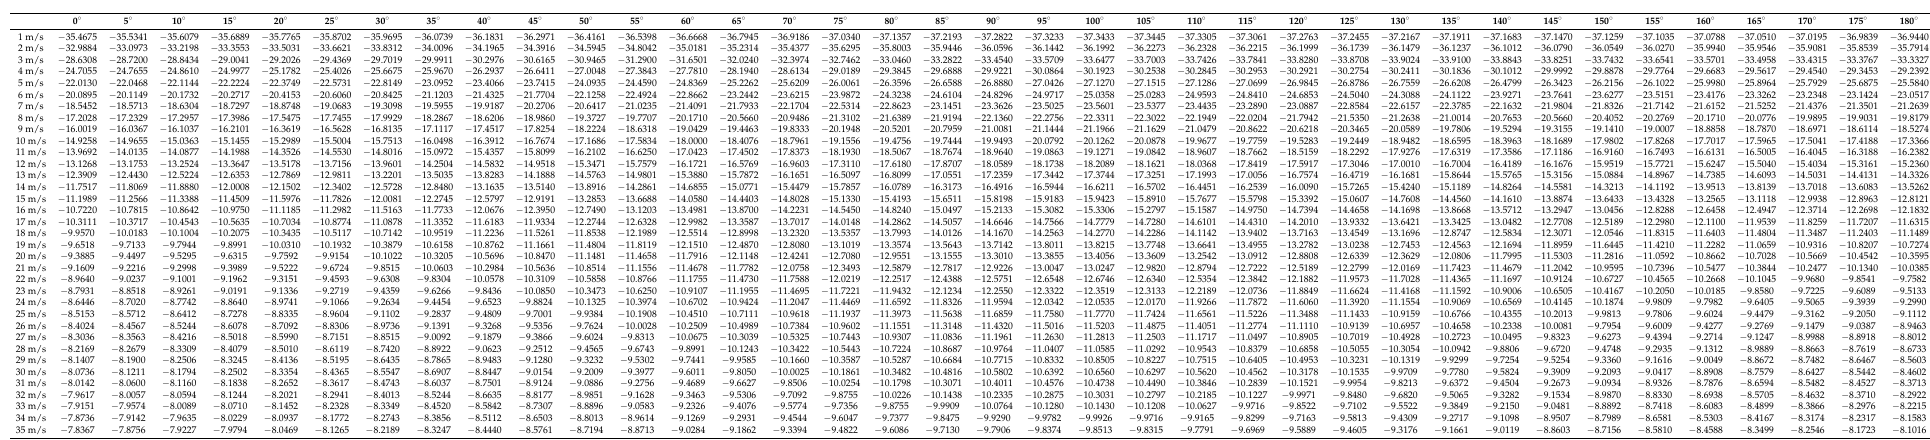
Table 3. The backscattering coefficients in HW-GMF of HH pol.